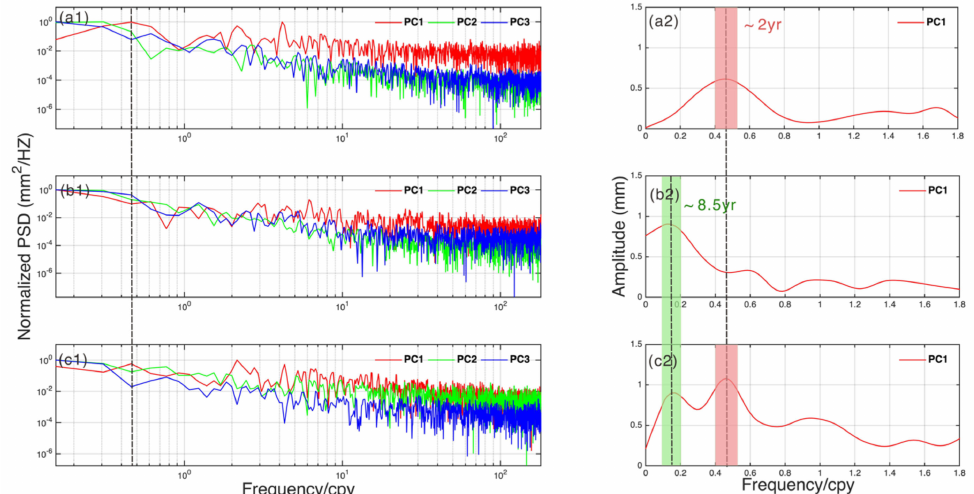
Figure 6. Normalized power spectra density of the first three principal components. ( a1 , b1 , c1 ) denote the east, north, and up directions, respectively. ( a2 , b2 , c2 ) denote the corresponding amplitude spectra of pc1, and the frequency ranges from 0 to 1.8 cycles per year